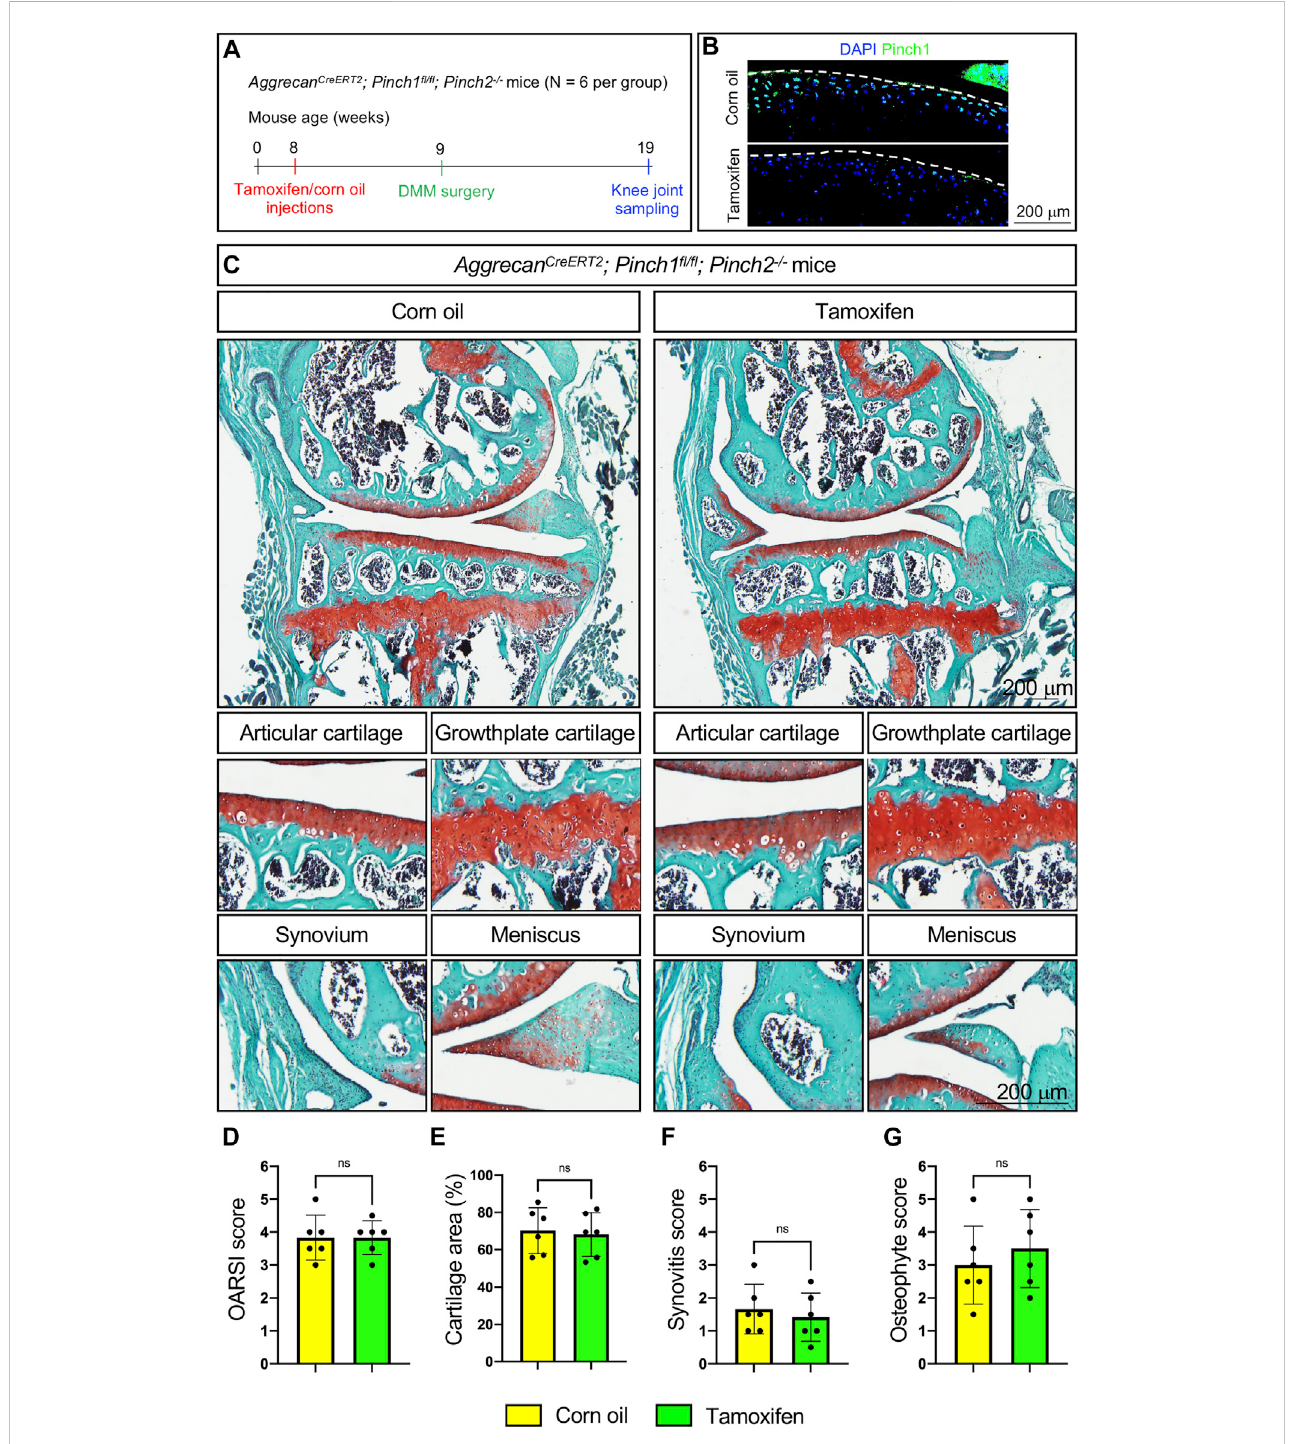
FIGURE 4 Pinch1/2 loss does not exacerbate surgically induced OA lesions in mice. (A) A schema illustrating the experimental design. (B) Immuno fl uorescence stainingofPinch1inarticularcartilage.Scalebar:200 μ m. (C) RepresentativesafraninOandfastgreen-stainedimagesofkneejointsections fromtamoxifen- or corn oil-treated Aggrecan CreERT2 ; Pinch1 fl ox/ fl ox ; Pinch2 − / − mice at 8 weeks after DMM surgery. Higher magni fi cation images in lower panels are showing the areas of articular cartilage, growth-plate cartilage, synovium, and meniscus. Scale bar: 200 μ m (D – G) Quantitative histological analyses of OARSI score, cartilage areas, synovitis score, and osteophyte score using knee joint sections. Note: N = 6 mice for each group. Results are expressed as mean ± standard deviation (s.d.). ns: not signi fi cant.